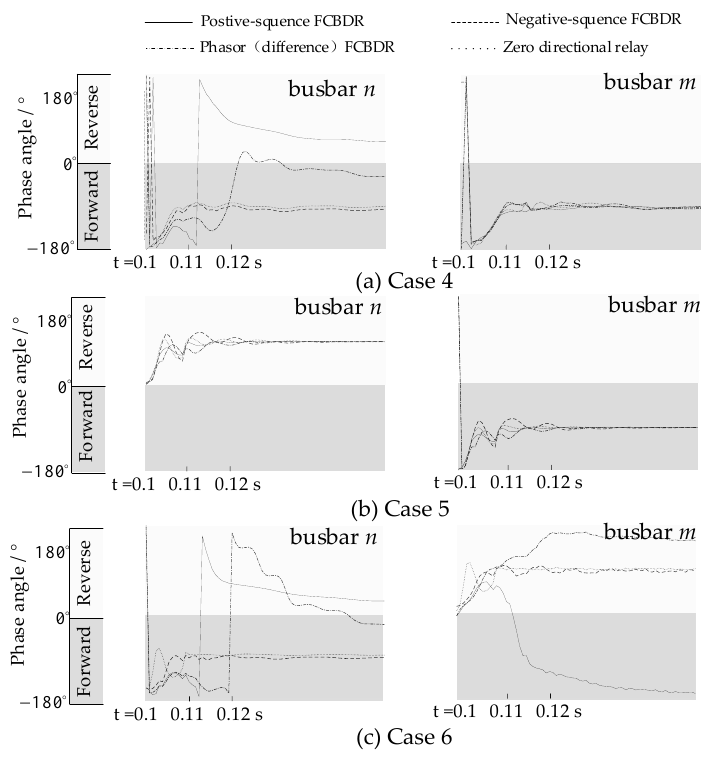
Figure 18. Performances of the conventional FCBDRs: ( a ) Case 4; ( b ) Case 5; and ( c ) Case 6. Case 4: Figure 18a shows that the positive-sequence and phasor (di ff erence) FCBDR at busbar